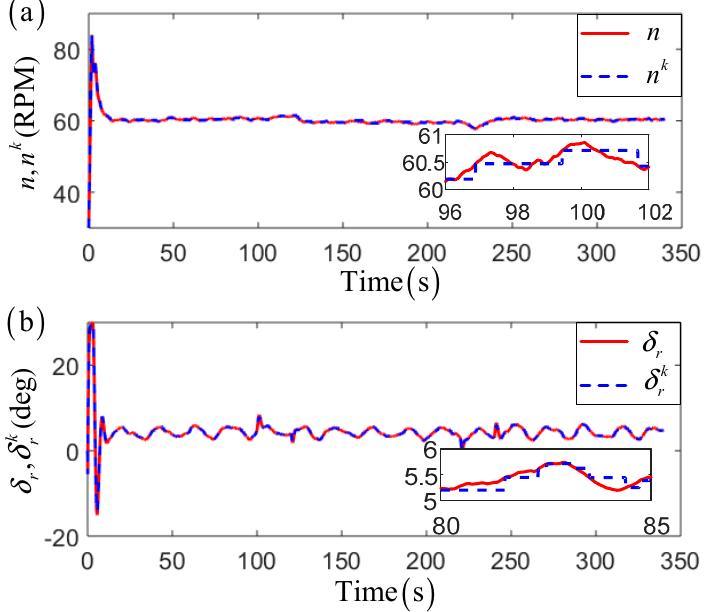
Figure 5. The control input for the USV (( a ) is the main engine speed. ( b ) is the rudder angle.).